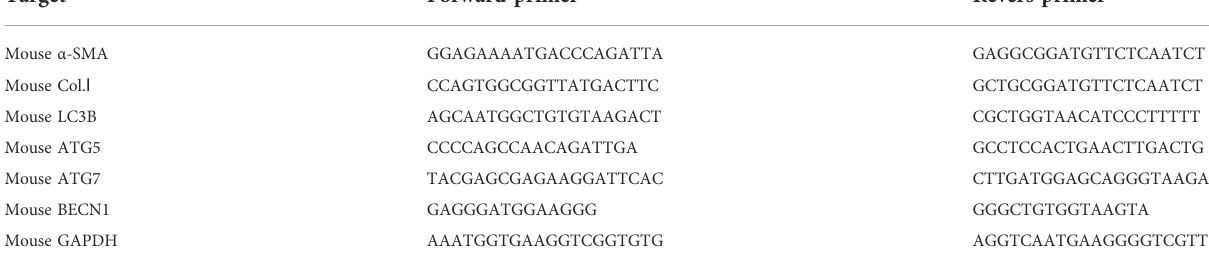
TABLE T1 Primers used for qPCR